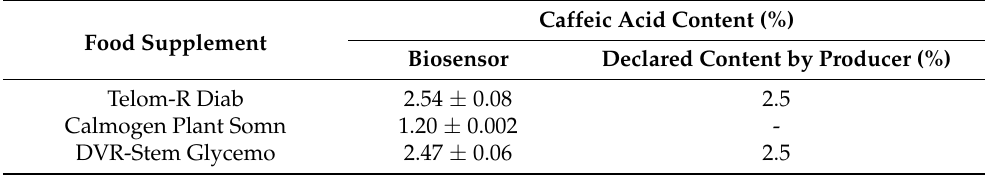
Table 4. Caffeic acid content in food